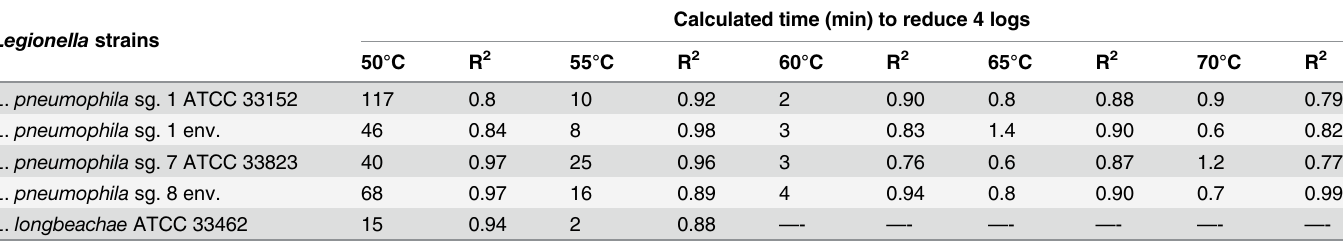
Calculated time (min) to reduce 4